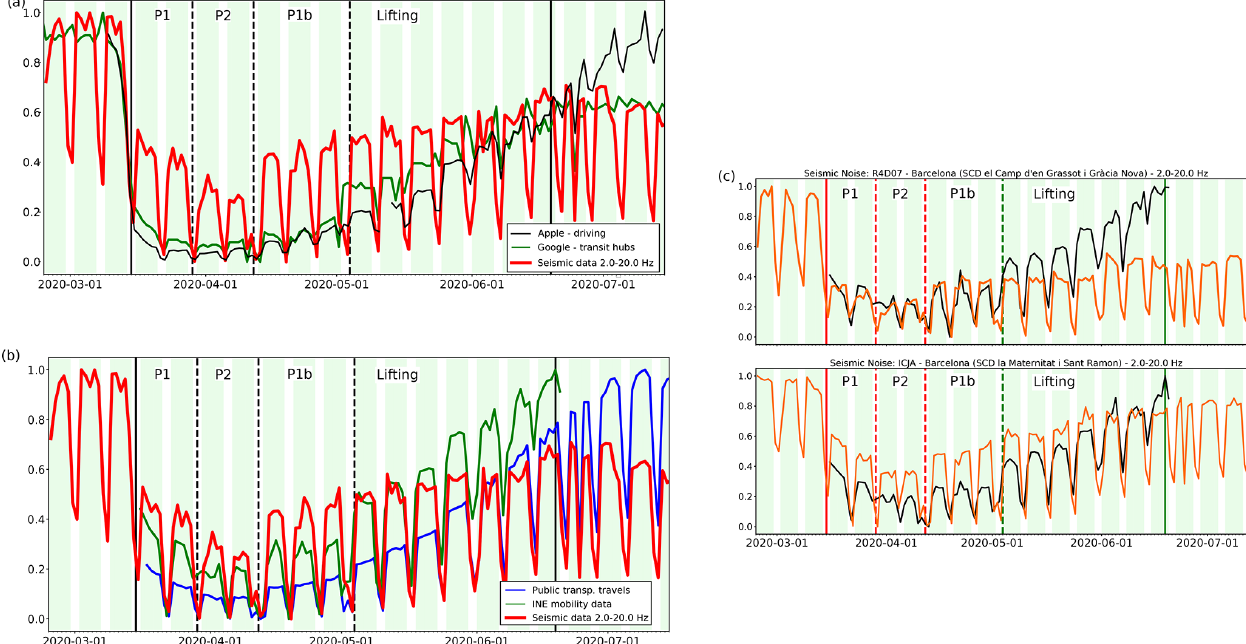
Figure 10. Mobility data from different sources compared to seismic data. (a) Normalized mean seismic power during business hours (09:00– 19:00) vs. mobility data from Apple and Google. (b) Normalized mean seismic power during business hours vs. the number of validations of public transportation and the INE mobility data averaged for the Barcelona area. (c) Normalized power (orange line) during business hours for stations R4D07 (upper panel) and ICJA (lower panel) and INE mobility data for the corresponding mobility zones (black